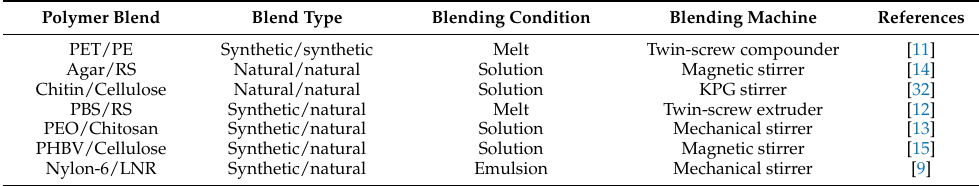
Table 3. Examples of polymer blends, blend types, blending conditions, and blending machines. Polymer